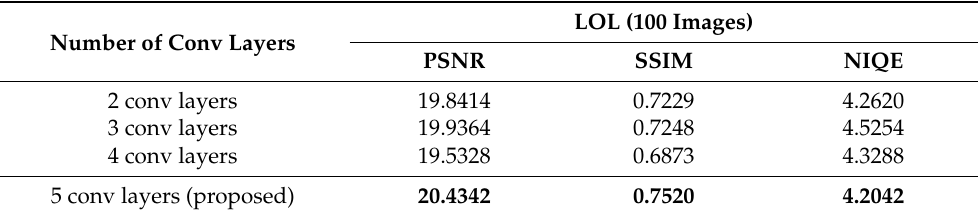
Table 4. Ablation study on the number of convolutional layers in RDBs. The best results are highlighted in boldface.